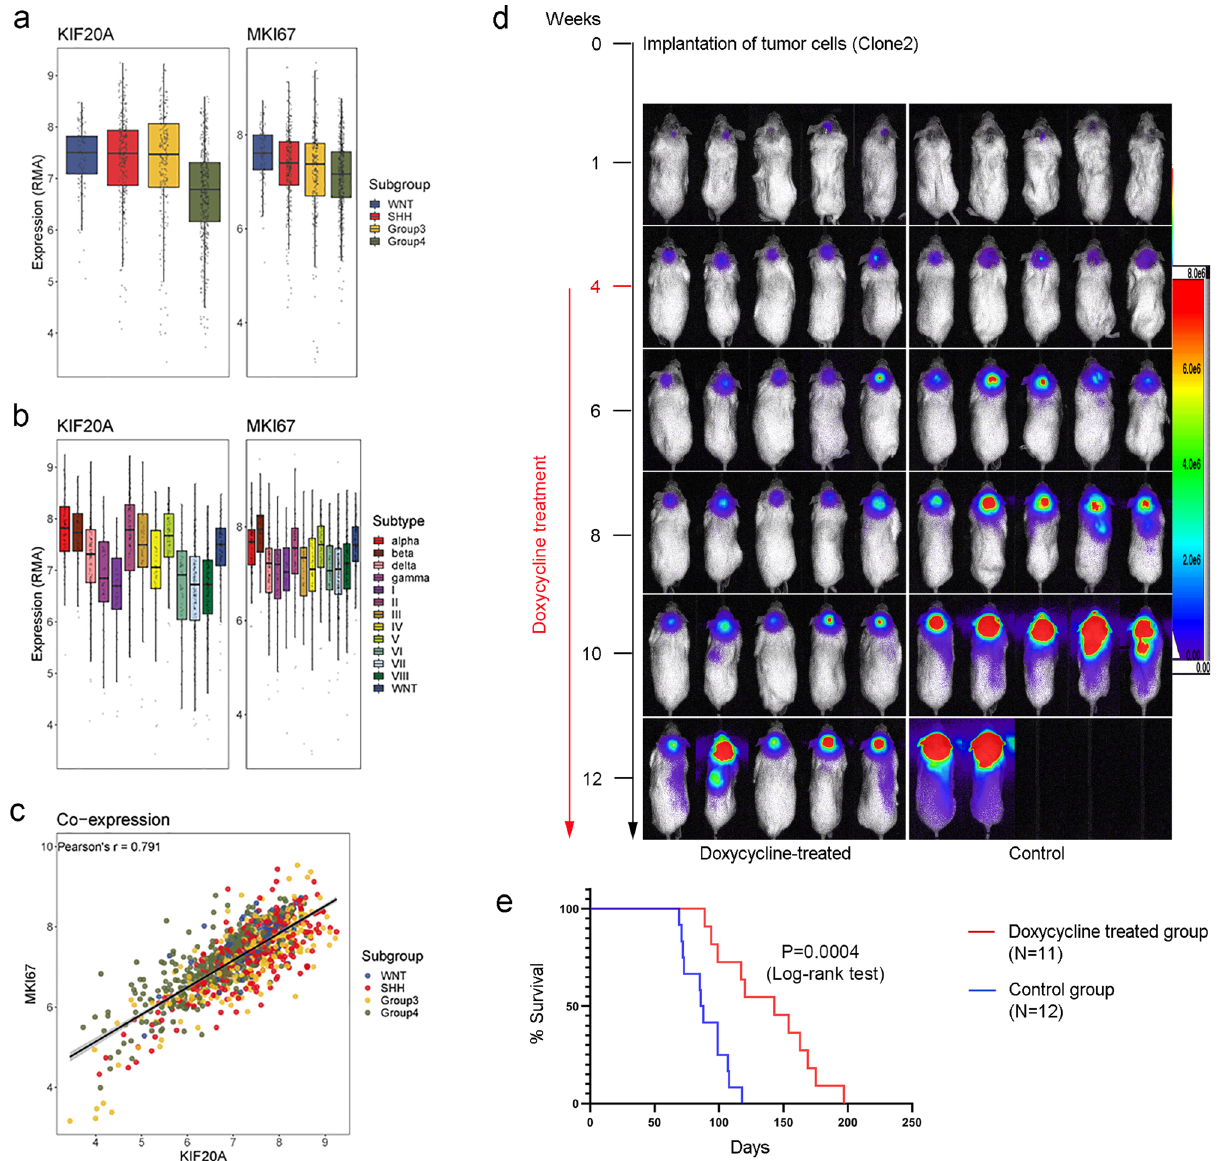
Fig. 6 Knockdown of KIF20A expression in human MB cells inhibits tumor growth. a Different subgroups of MB patient cells display strong expression of KIF20A, which is positively correlated with proliferating cell marker Ki67. b KIF20A and Ki67 expressions are also positively correlated in different subtypes of human MB cells. c Comparison between KIF20A expression and Ki67 expression in subgroups of human MB cells. Expression of the two factors are highly correlated. d Daoy cells stably integrated with Tet-on shKIF20A726 and fi re fl y luciferase were intracranially injected into the cerebellar areas of recipient NSG mice (10 5 cells per mouse). Tumor growths were monitored by bioluminescence imaging. Doxycycline treatment started at 4 weeks after the initial cell implantation (indicated with a red font and line). The treatment group of mice was fi rst given doxycycline by gavage for 2 consecutive days and was then fed with doxycycline-containing food for the entire duration of the experiment. e Survival data were analyzed by Kaplan – Meier